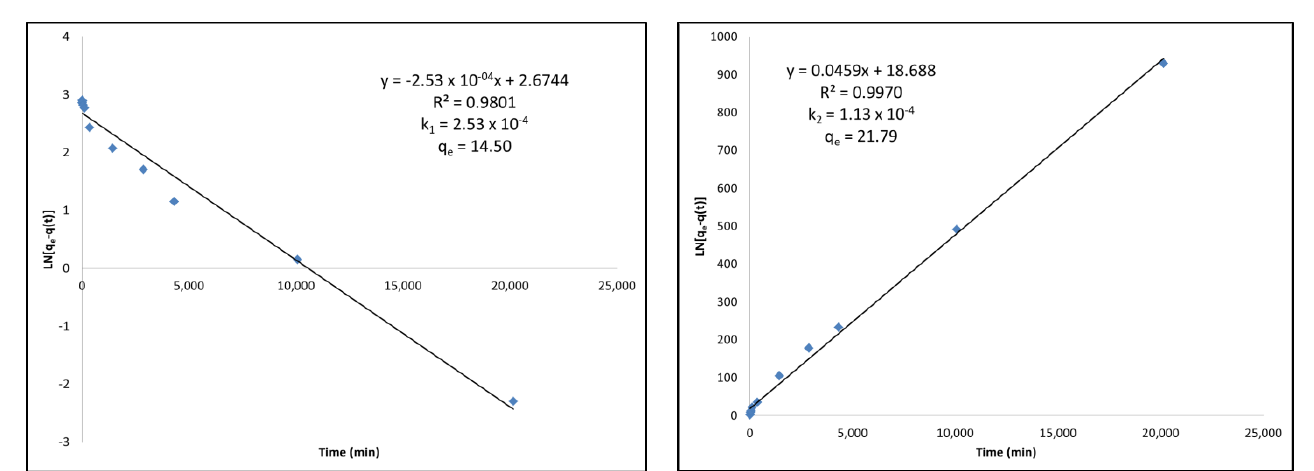
Figure 4. ( Left ) Pseudo-first-order kinetic modeling of commercial activated carbon under Langmuir adsorption kinetics equations. ( Right ) Pseudo-second-order kinetic modeling of commercial activated carbon under Langmuir adsorption kinetics equations.